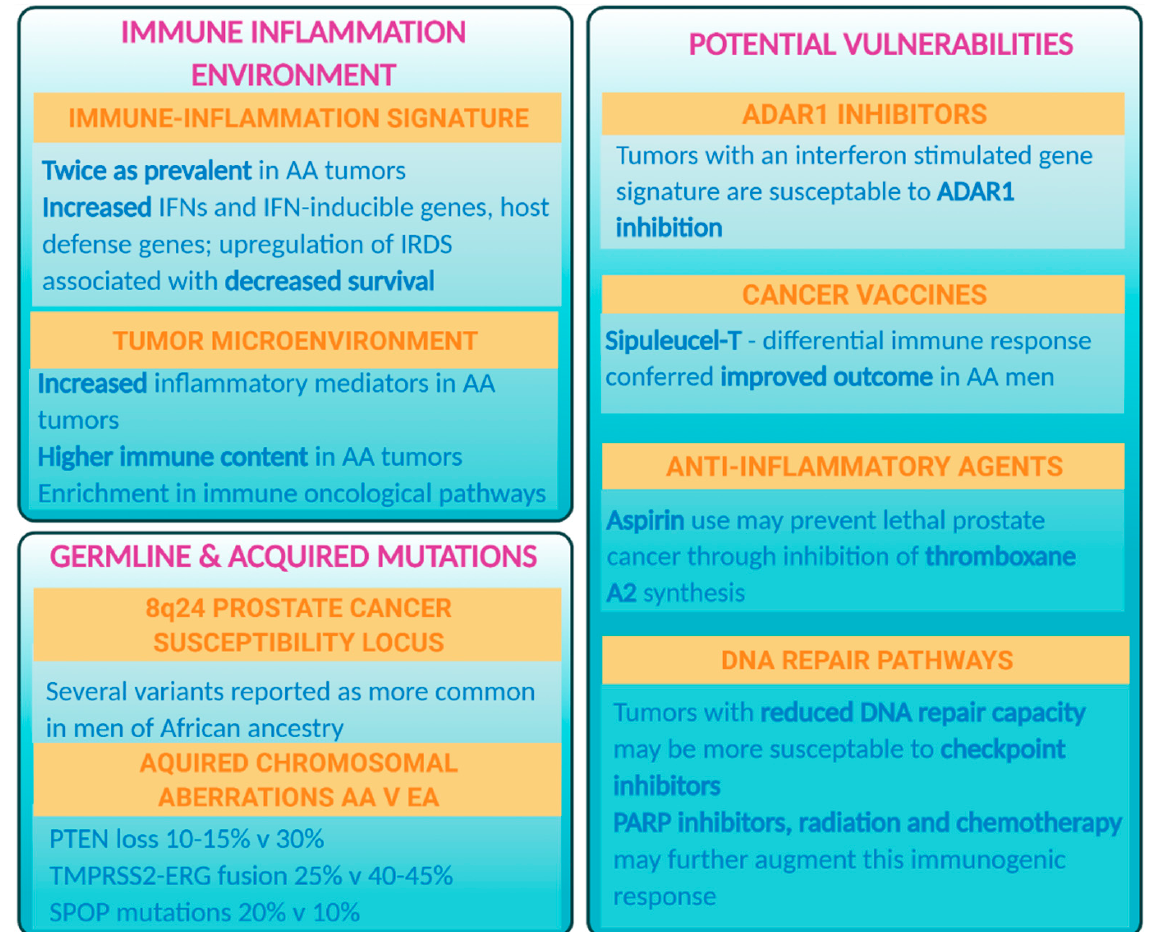
Figure 1. Key differences in the tumor immune–inflammation environment and the mutational spectrum between African American and European American men with prostate cancer. These differences open up potential vulnerabilities which preliminary studies have indicated could be exploited with treatment options, with some of them having demonstrated favorable responses in African American men.